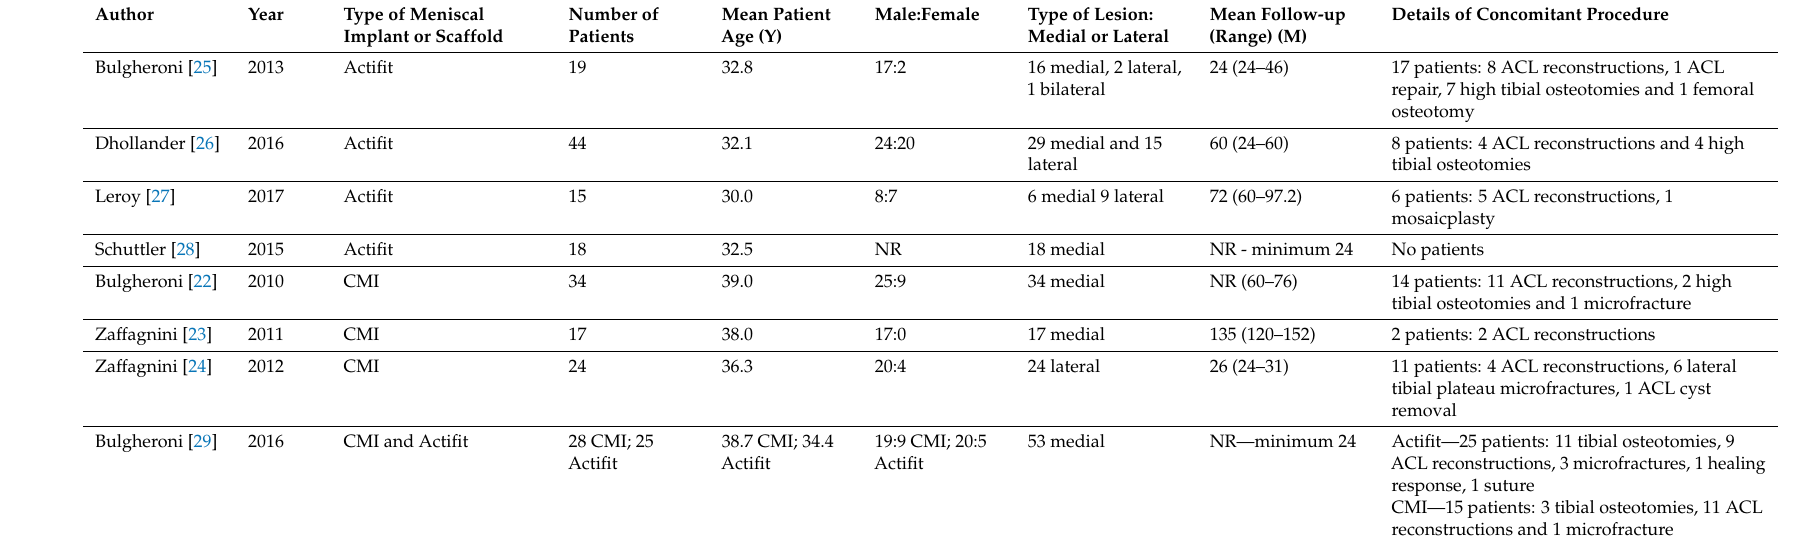
Table 1. The study demographics and